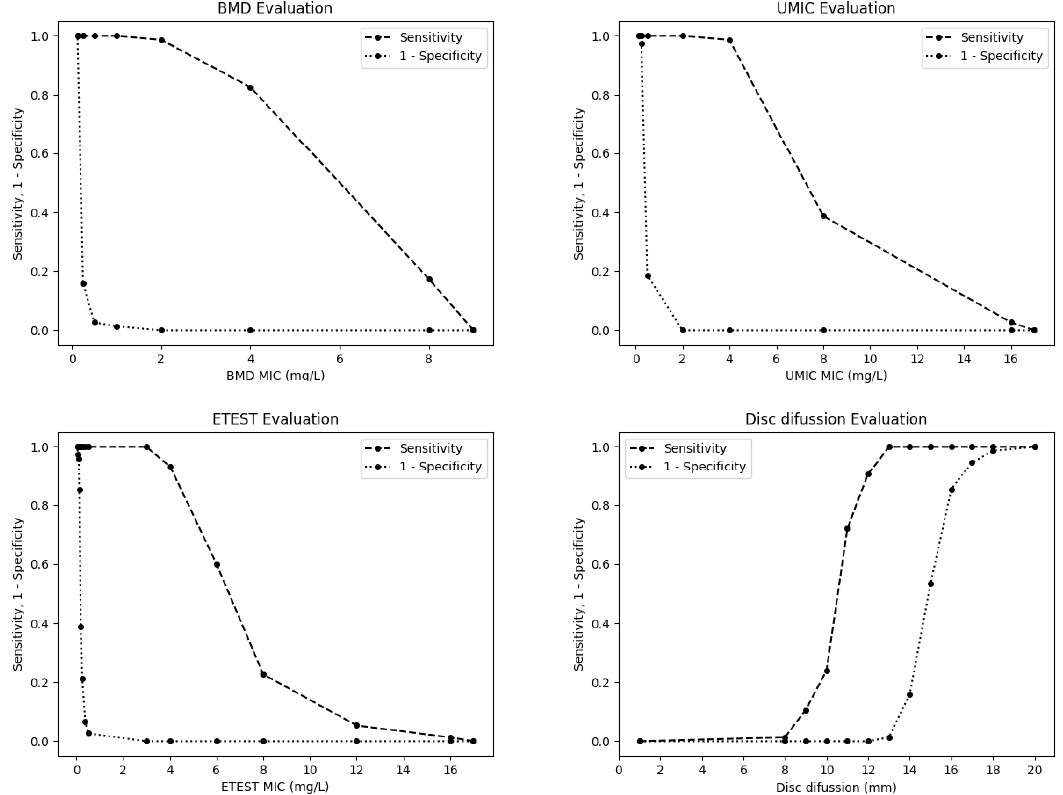
Figure 4. Sensitivity and specificity of the BMD, UMIC ® , Etest ® and disc di ff usion methods for the detection of mcr -carrying E. coli isolates at di ff erent thresholds.